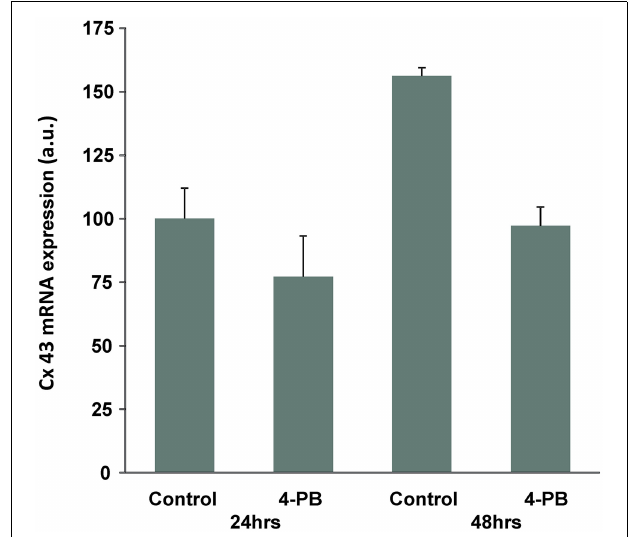
FIGURE 2 | Effect of 4-PB treatment on Cx43 mRNA expression in corpora cells. Real-time PCR analysis of the Cx43 gene expression in Frc cells treated with vehicle (Control) and 5mM of the drug (4-PB) for 24 and 48h. The columns represent average expression values (normalized to the 24h control) and the bars are s.e.m. ( n =